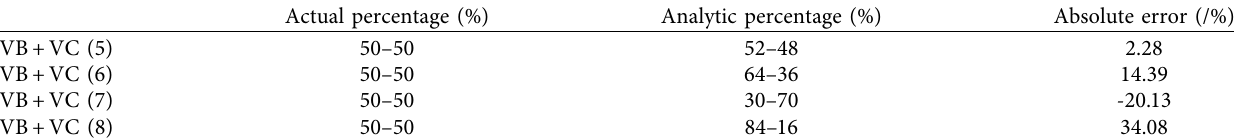
Table 6: Analytic percentage, actual percentage, and absolute error between them of the vitamin samples VB+VC (5)